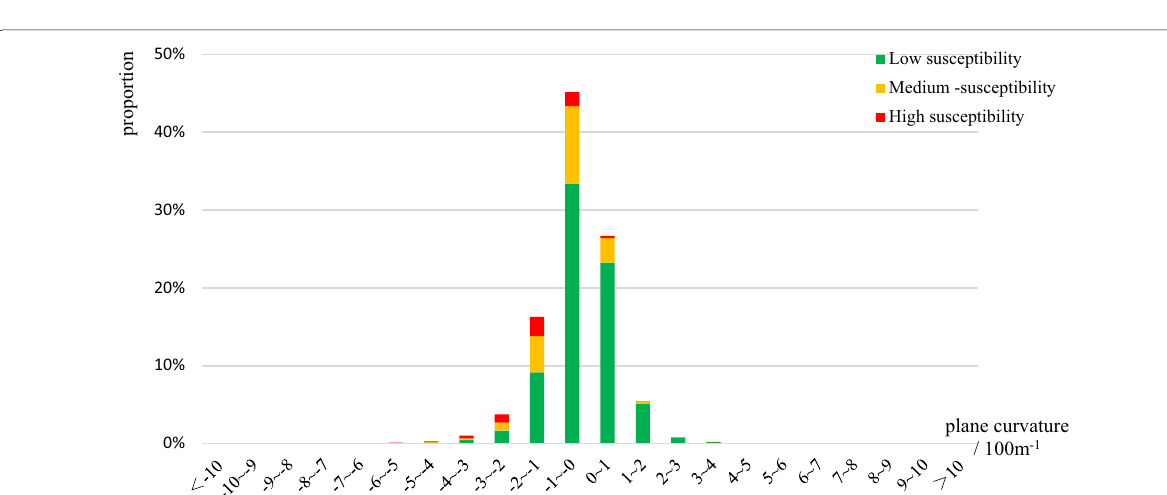
Fig. 13 Relationship between debris flow susceptibility and plane curvature